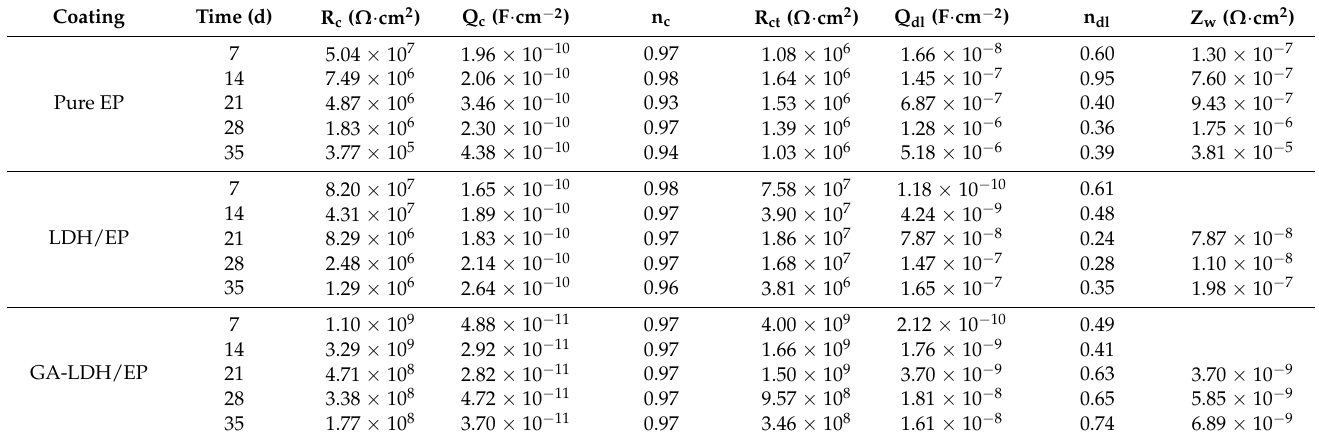
Table 1. Values of electrochemical corrosion parameters obtained by fitting EIS